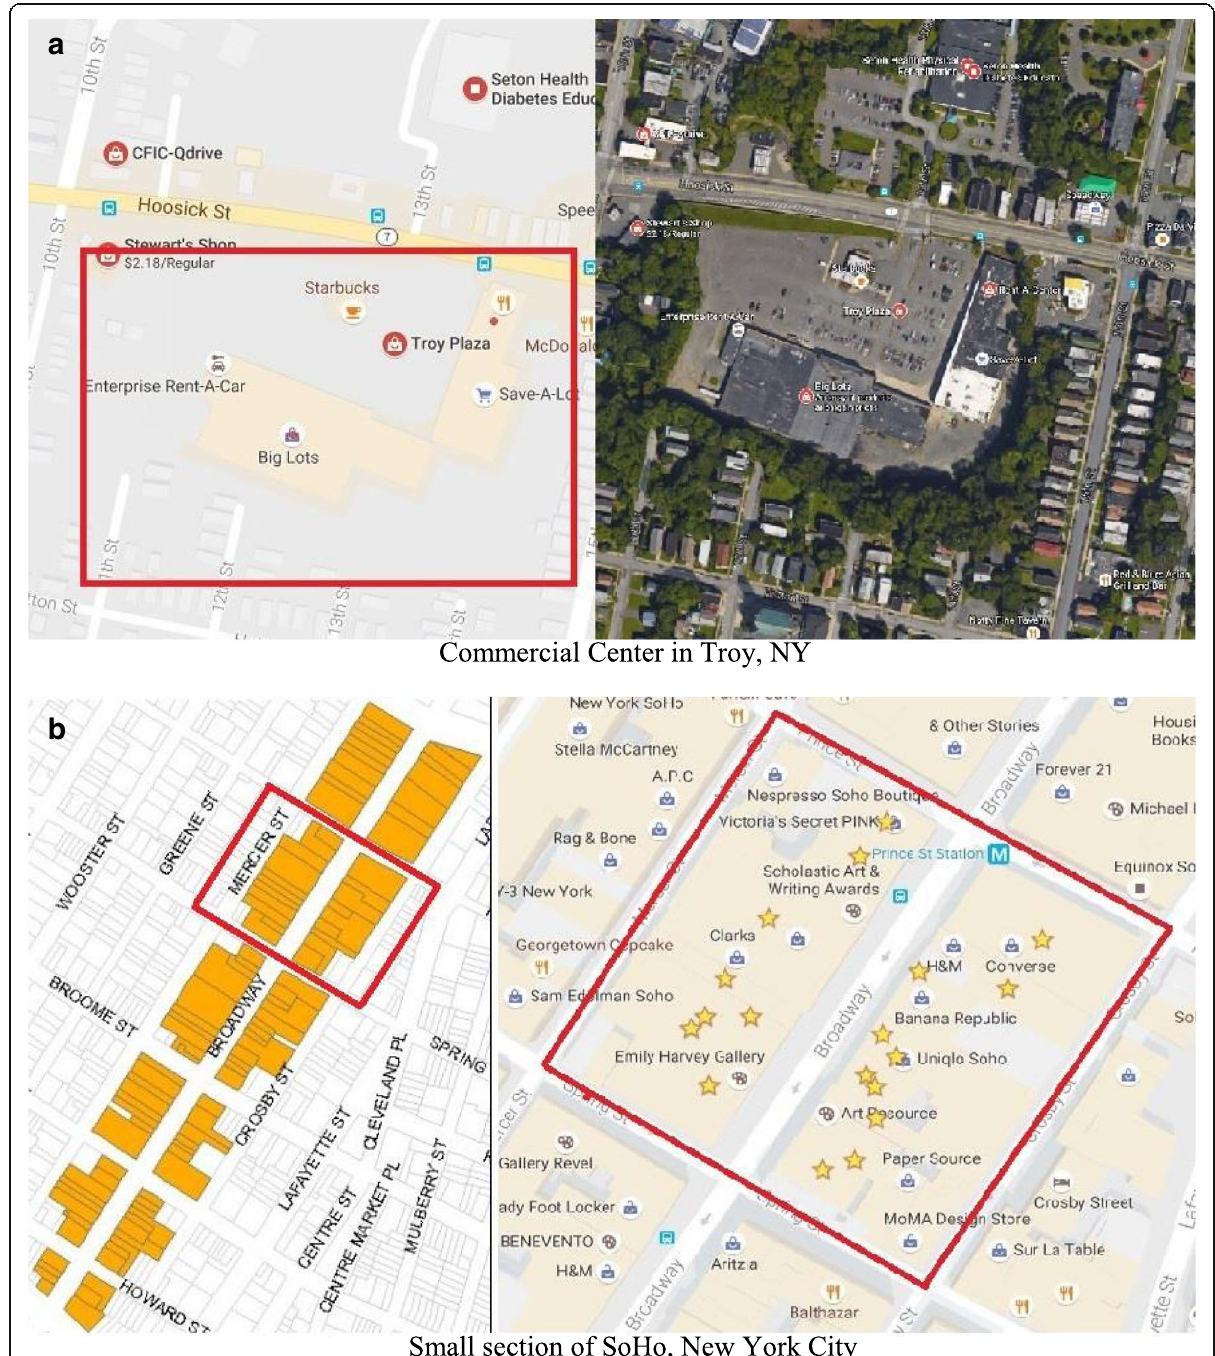
Fig. 1 Schematics of Case Studies: a Commercial Center in Troy, NY; b Small section of SoHo, New York